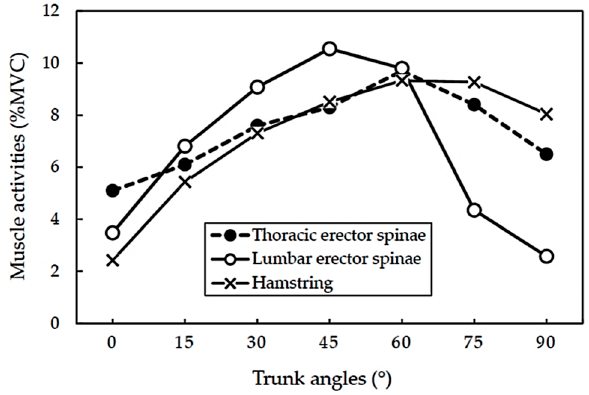
Table 5. Muscle activity and LSA of Duncan groups with varying trunk angles.